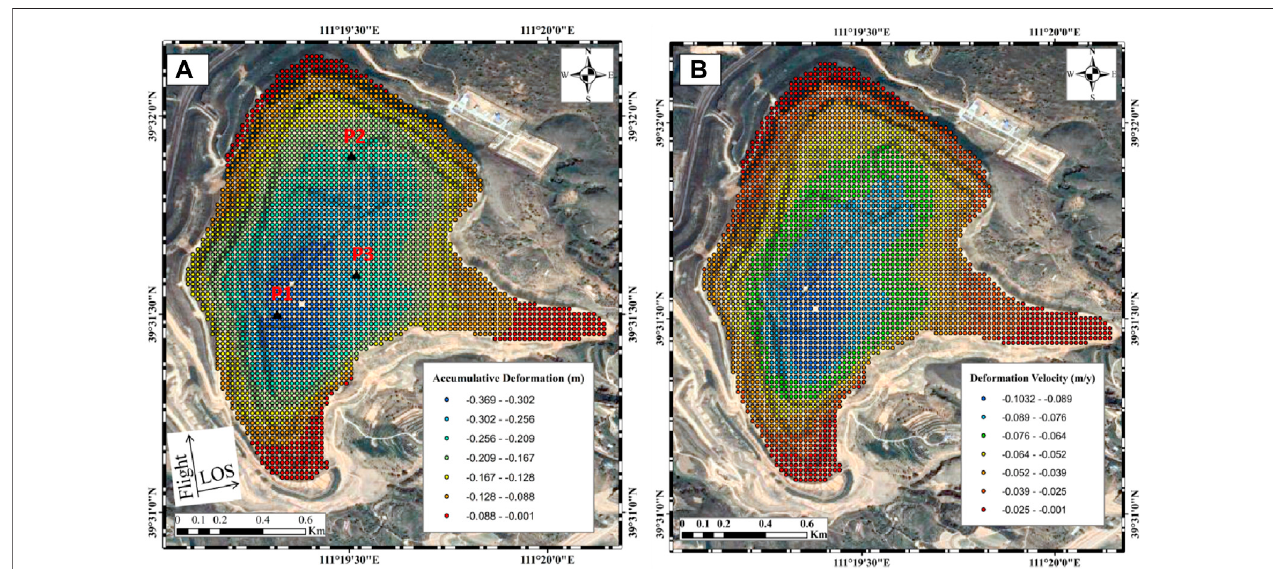
FIGURE4| Accumulativesettlement (A) andtheannualsettlementvelocity (B) overthefocusedminewastedumpintheperiodfrom30May2017to14May2020.